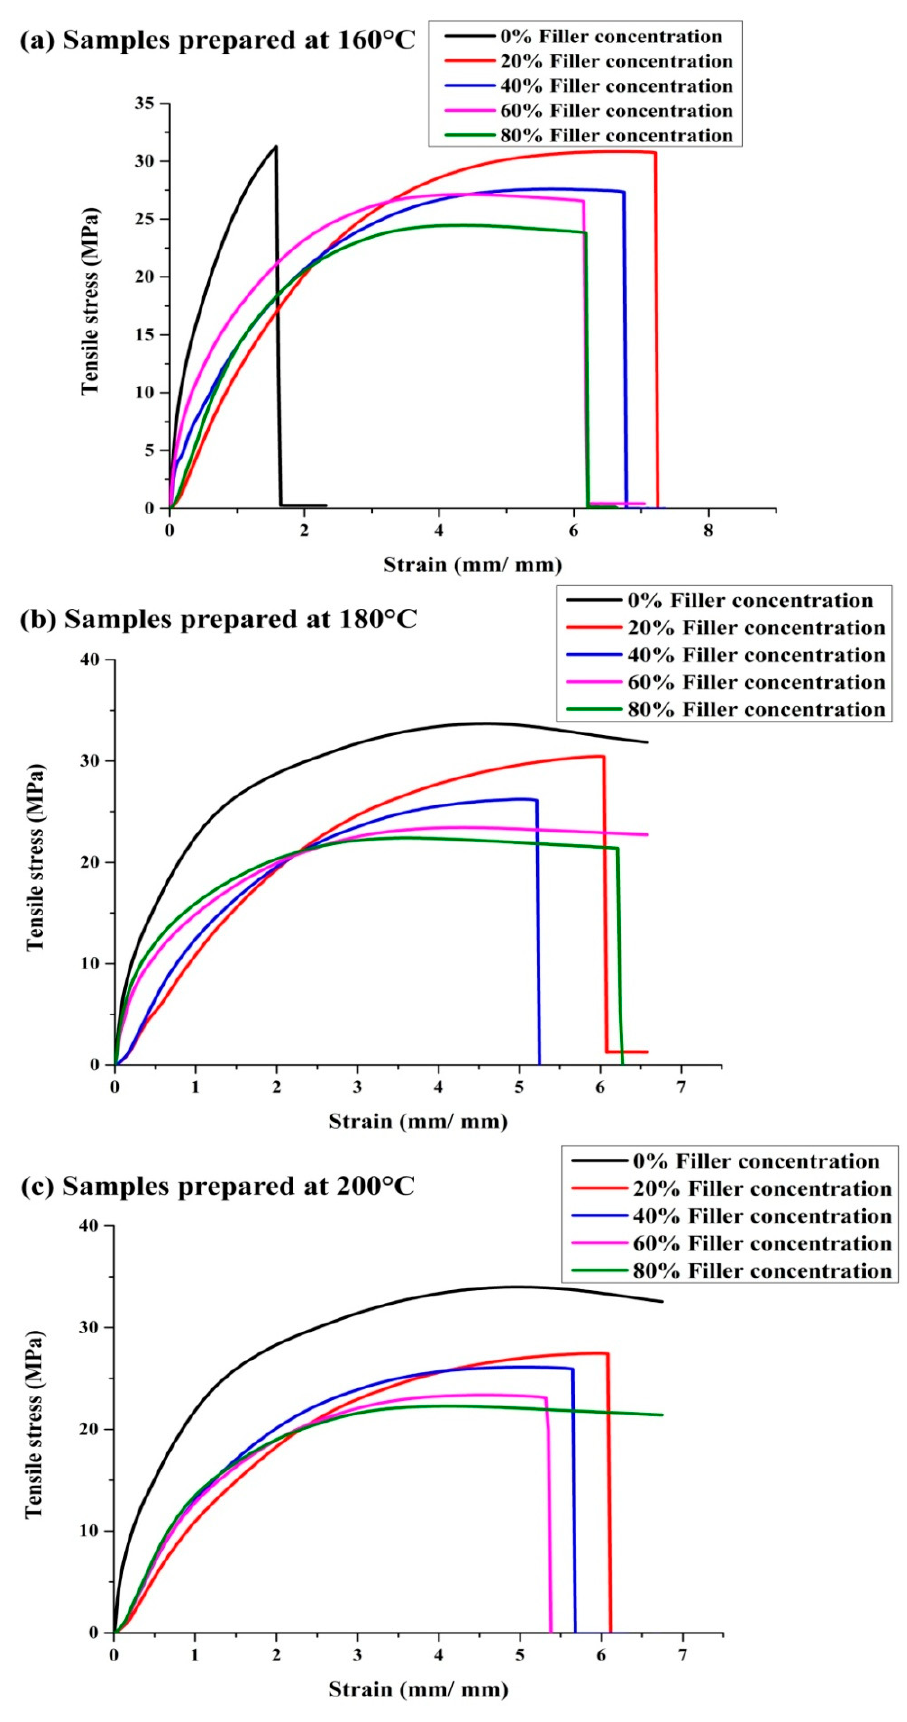
Figure 8. Stress–strain behavior of MP-PP composites/PP prepared at ( a ) 160, ( b ) 180, and ( c ) 200 °C. The flexural strength of pristine PP and marble waste particulate (MP)-filled polymer composites (Figure 7d) fabricated by the injection molding technique in the polypropylene (PP) system was also determined. The flexural strengths of 0, 20, 40, 60, and 80 wt. % filler-content polymer composites fabricated at an injection molding temperature of 160 °C were found to be 59.96,